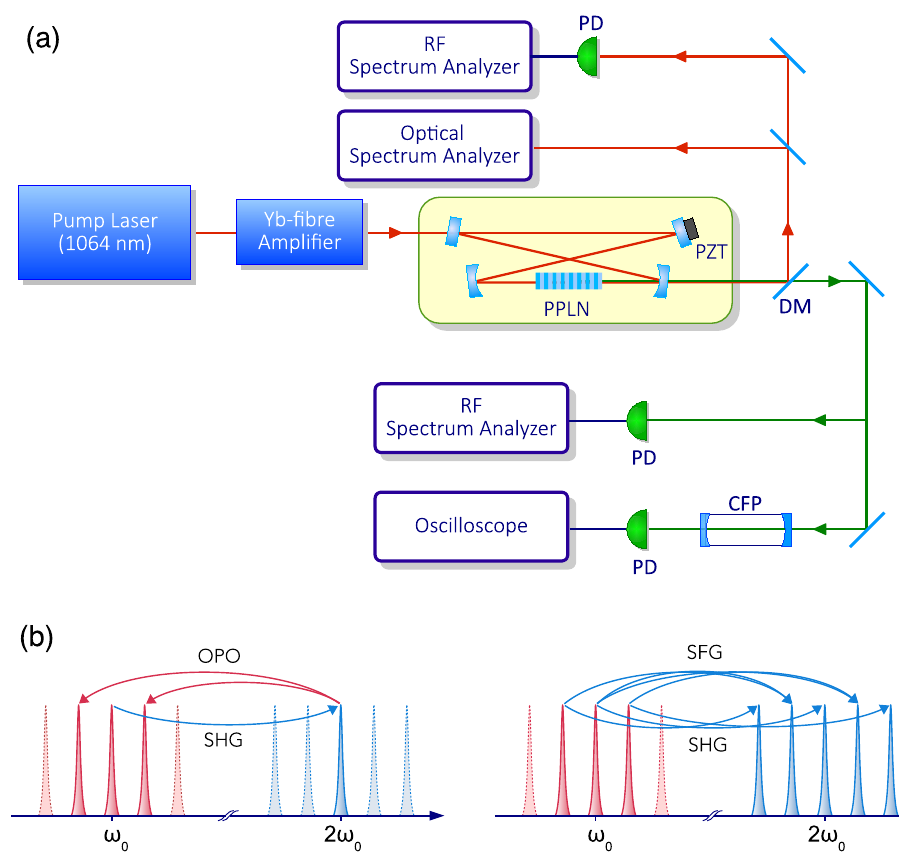
Figure 1. Singly resonant cavity second harmonic generation (SHG). ( a ) Experimental setup: periodically poled lithium niobate crystal (PPLN), piezoelectric actuator (PZT), photodiode (PD), dichroic mirror (DM). The output beams are detected and processed by radio-frequency (RF) analyzers, while optical spectral analysis is performed by an optical spectrum analyzer in the infrared range and a confocal Fabry-Pèrot interferometer (CFP) in the visible range. ( b ) Schematic representation of the first steps leading to the formation of a dual optical frequency comb in cavity-enhanced second-harmonic generation: (left) second-harmonic generation with cascaded nondegenerate optical parametric oscillator (OPO) gives rise to two subharmonic sidebands, which in turn (right) lead to successive, multiple second-harmonic and sum-frequency generations. Adapted with permission from [48]. Copyrighted by the American Physical